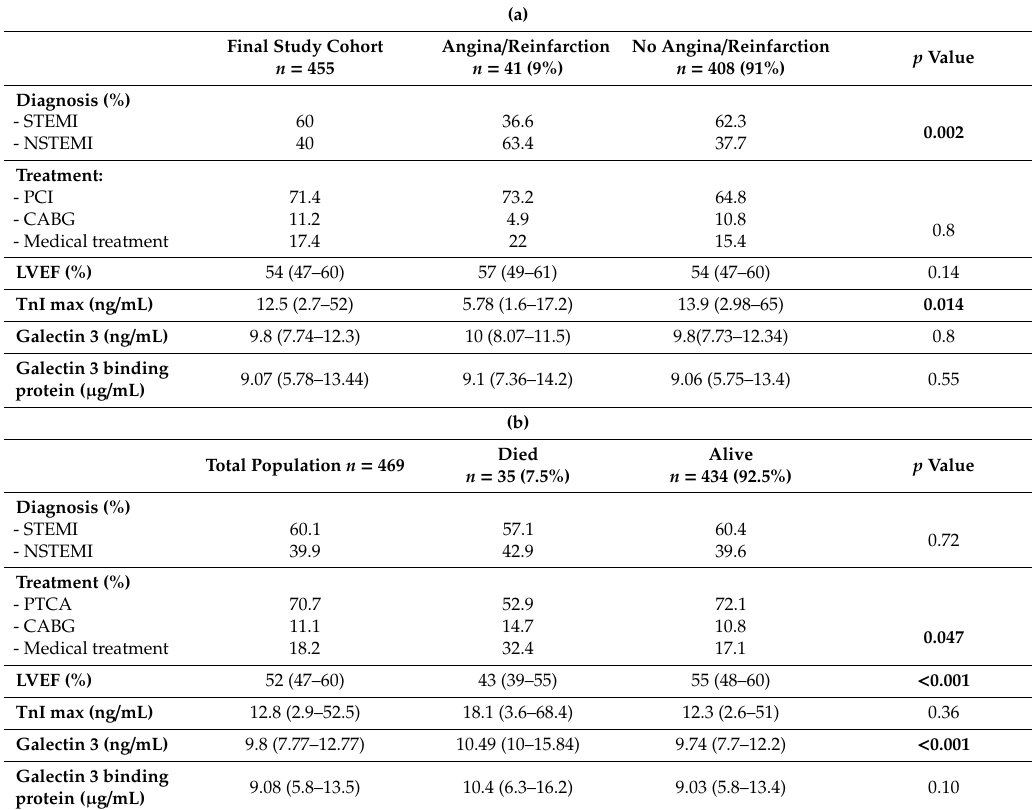
Table 2. (a) Main characteristics of patients stratified by the end-point recurrent angina with need of rehospitalization / revascularization or myocardial infarction. (b) Main characteristics of patients stratified by the end-point